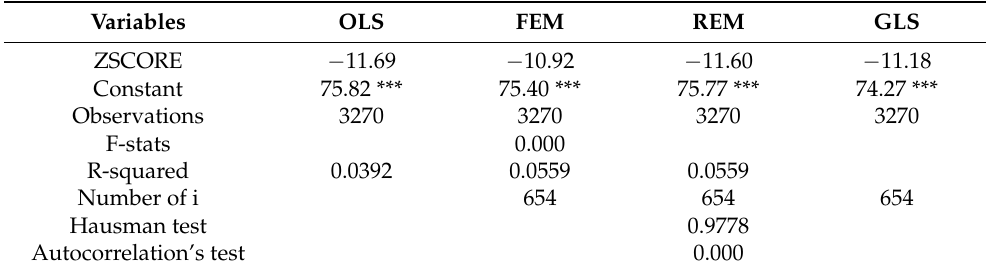
Table 8. Regression results of effects of bankruptcy to time of publication annual reports in research model